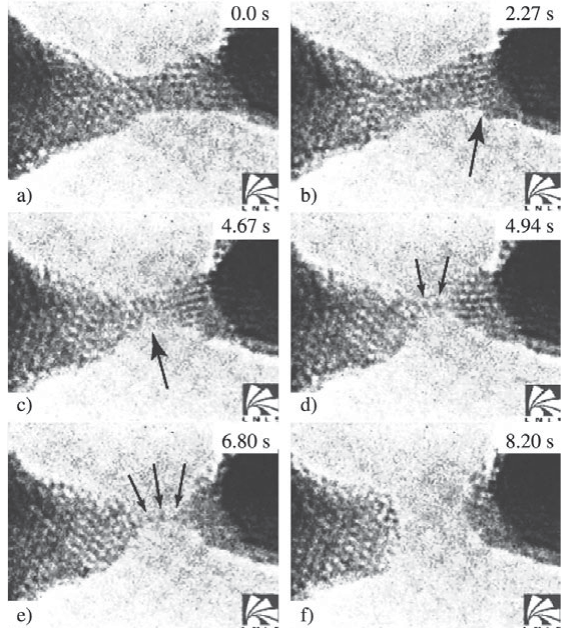
Figure 1. Gold nanowire time evolution. An ATC with two atoms is formed in (d), and in (e) the number of atoms have increased to three in the linear chain (indicated by arrows). See text for discus-